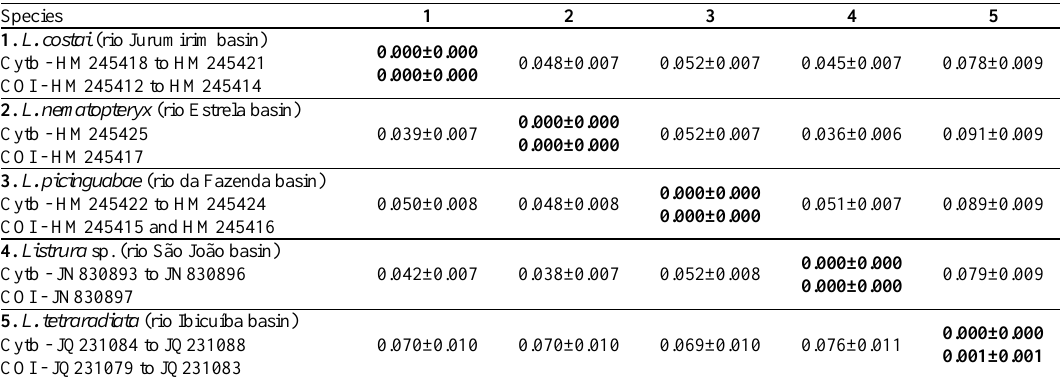
Table 2. Pairwise mtDNA Kimura 2 Parameter genetic distance values (mean ± standard error) for cytochrome b gene (above diagonal) and cytochrome oxidase c subunit 1 gene (below diagonal) between Listrura costai , L. nematopteryx , L. picinguabae , Listrura sp., and L. tetraradiata . Diagonal shows the intraspecific genetic distance values for Cytb (above) and COI (below). Alpha-numeric codes below species names are GenBank accession